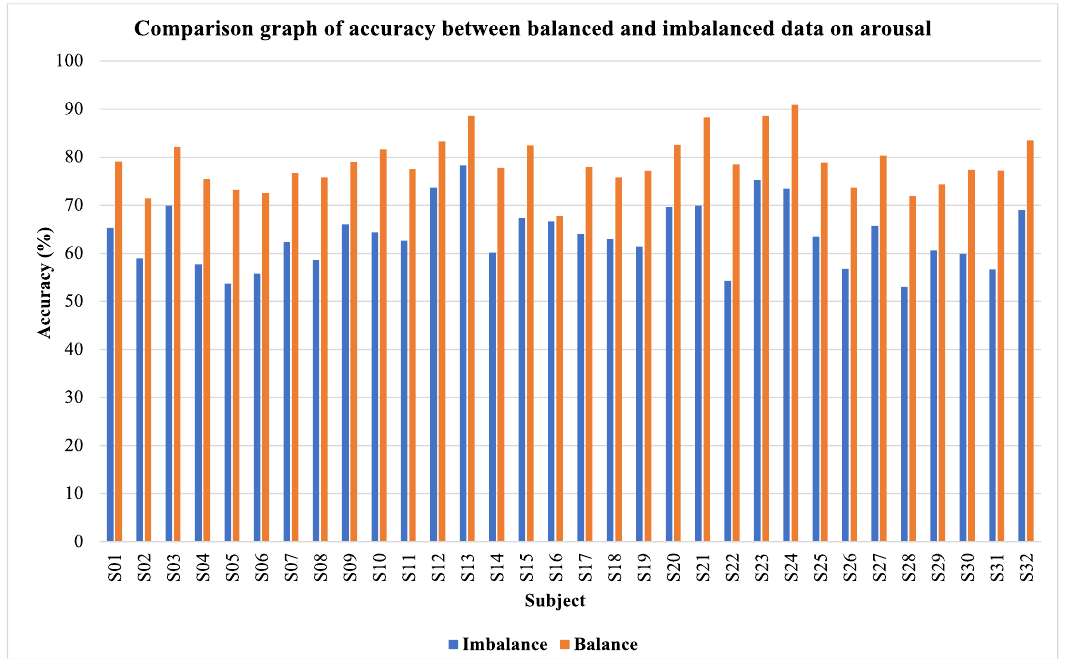
Figure 12. Comparison of arousal accuracy for using Decision Tree and with or without the Radius SMOTE